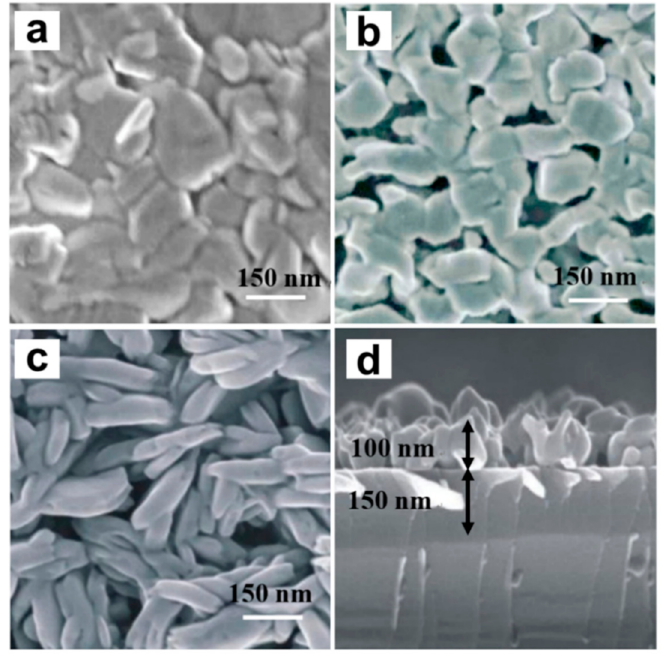
Figure 4. ( a ) S1; ( b ) S2; ( c ) S3; ( d ) S3 surface morphology cross-sectional field-emission scanning electron microscopy (FESEM) image.